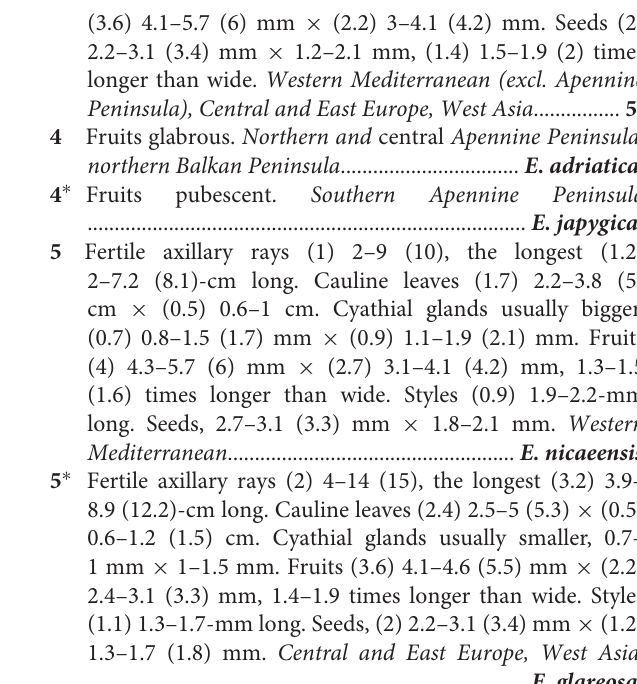
(Radcliffe-Smith and Tutin, 1968) to distinguish between E. glareosa s.l. and E. nicaeensis s.l., i.e., the number of rays and capsule size, have proved to be highly overlapping between the two taxa (see species descriptions below). In the following key, several morphological characters, therefore, overlap, but a combination of several characters with geographic data makes unambiguous identification